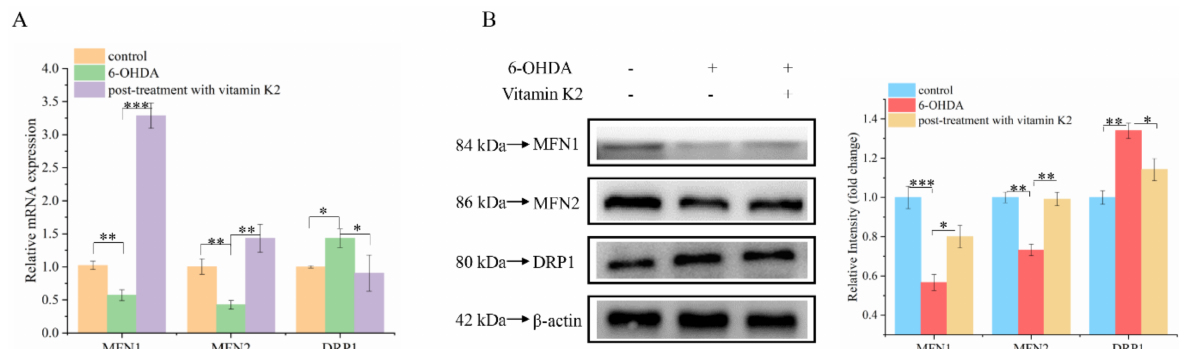
Figure 5. Effect of vitamin K2 on mitochondrial dynamic balance in 6-OHDA-injured cells. ( A ) Mea- surement of MFN1, MFN2, and DRP1 mRNA expression changes by using RT-qPCR. ( B ) Changes in protein expression levels of MFN1, MFN2, and DRP1 detected by Western blot; images were quantified by using the ImageJ software. The data are presented as mean ± SD ( n = 3). Significant difference * p < 0.5, ** p < 0.05, and *** p < 0.01 vs.